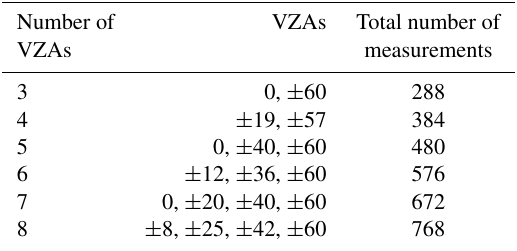
Table 5. List of the viewing angles in the evaluated MAP-mod se-